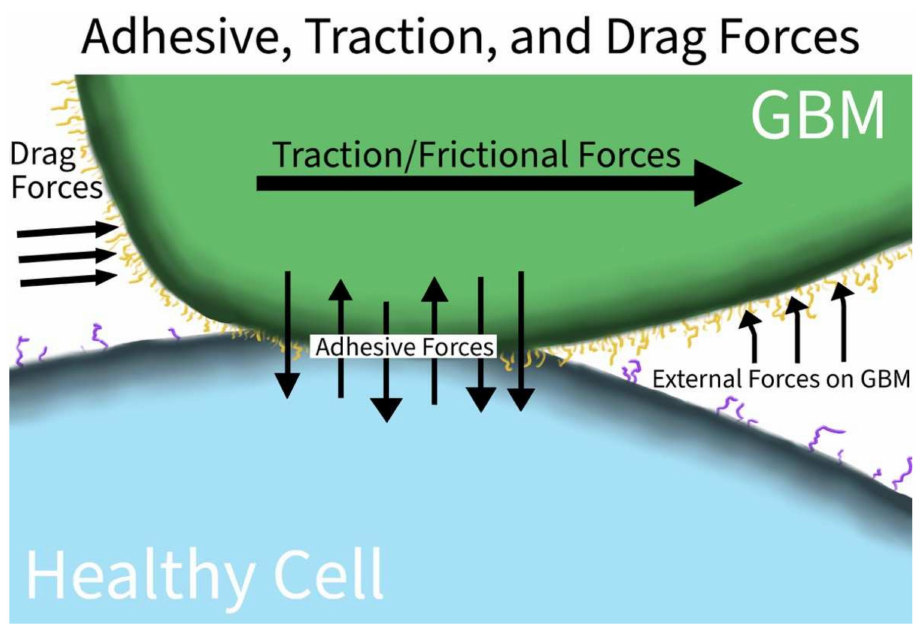
Figure 4. Adhesive, Traction, and Drag Forces in GBM. GBM upregulates various surface proteins, enabling it to adhere to the surfaces of healthy tissue; the increased adherence also helps GBM to resist the physical forces of other tissues or fluids via increased traction forces directly at the surface interface and drag forces at the free margins of the